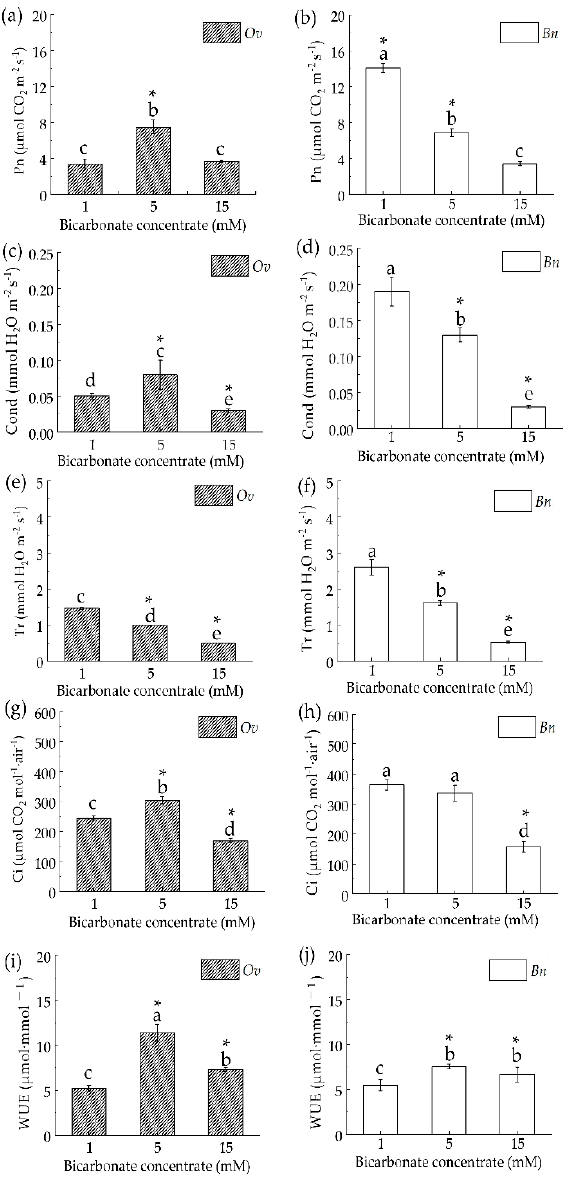
Figure 1. The photosynthesis of Ov and Bn under different bicarbonate supplies. Ov — Orychophragmus violaceus , Bn — Brassica napus , Pn-net—photosynthetic rate, Cond—stomatal conductivity, Tr—transpiration, Ci—intercellular carbon dioxide concentration, and WUE—water use efficiency. ( a , b ) — The Pn of Ov / Bn , ( c , d ) — The Cond of Ov / Bn , ( e , f ) — The Tr of Ov / Bn , ( g , h ) — The Ci of Ov / Bn , ( i , j ) — The WUE of Ov / Bn . The ratio of nitrate/ammonium within consistent total nitrogen concentration was 14 mM:1 mM under various bicarbonate treatments. Each value represents the mean ± SD ( n = 3), and diverse letters with “*”in each value are significantly different by ANOVA ( p > 0.05).